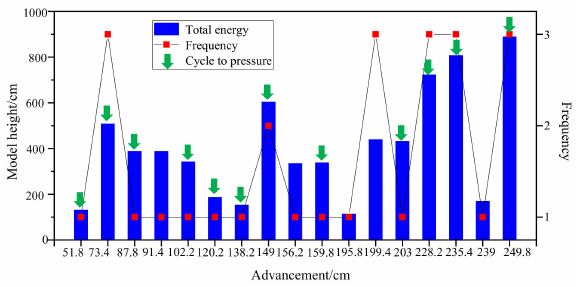
Figure 12. Microseismic energy-frequency characteristics of overlying